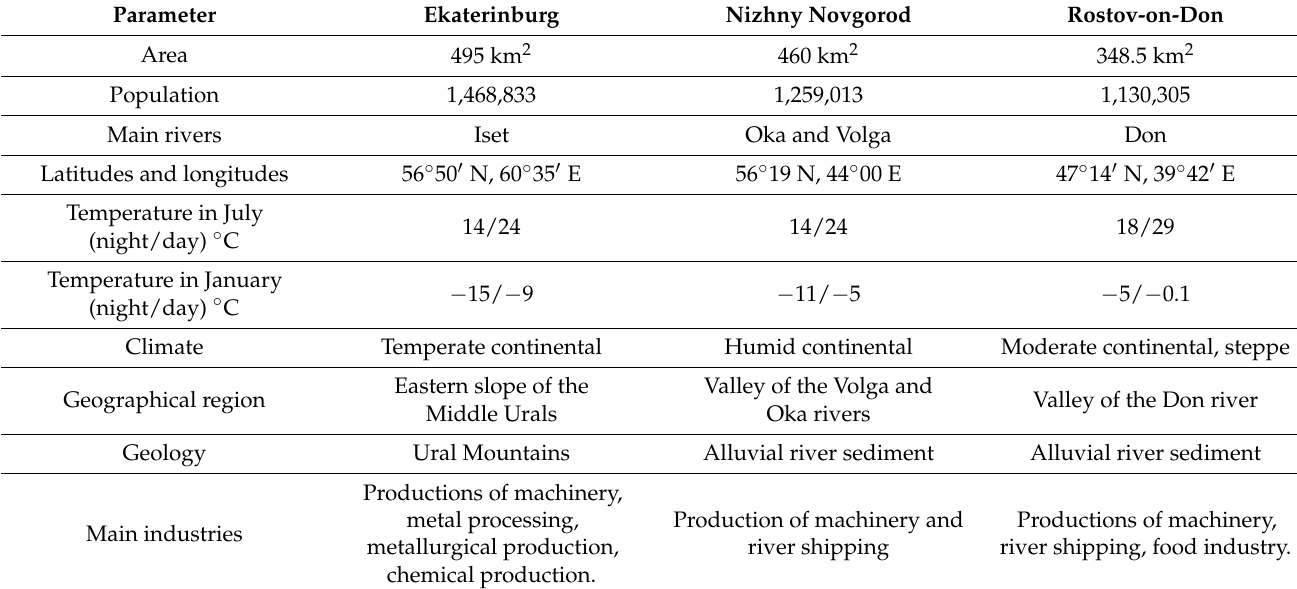
Table 1. Description of the investigated